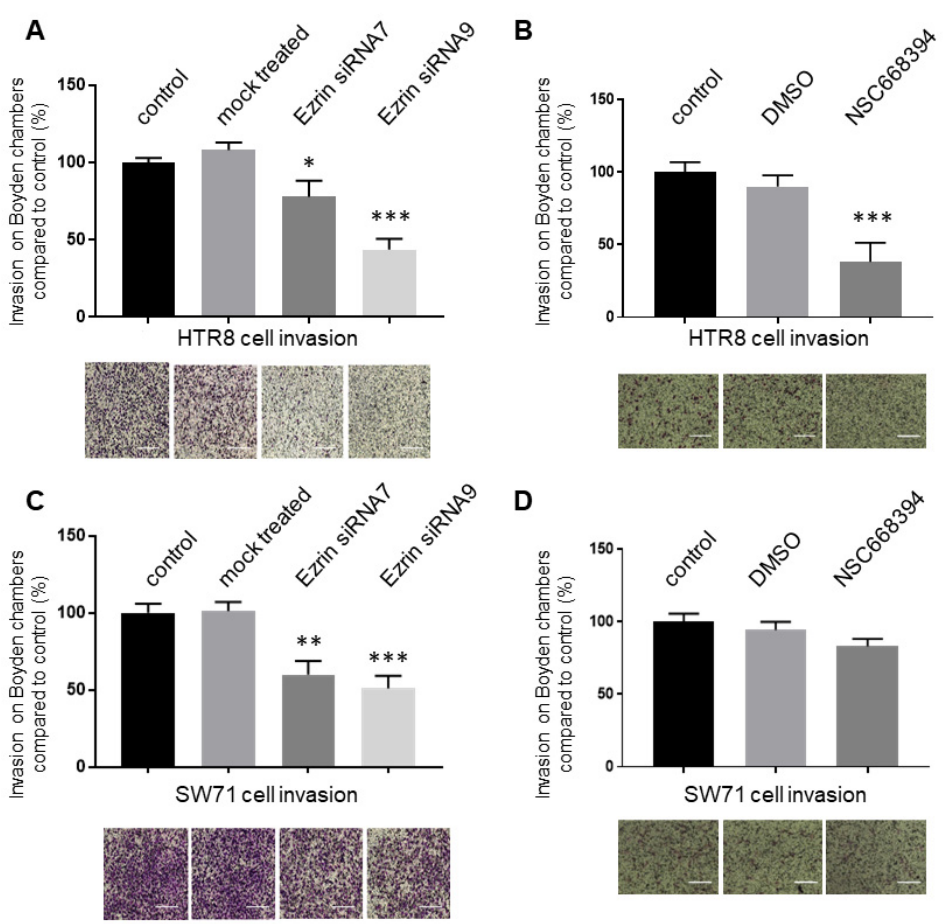
Figure 5. Reduced ezrin levels or its Thr567phosphorylation results in the differentially reduced cellular invasion of HTR8/SVneo and Swan71 trophoblasts. HTR8/SVneo and Swan71 cells were incubated in the presence of different ezrin siRNAs or control siRNAs for 72 h ( A , C ) or treated with NSC668394 inhibitors for 24 h ( B , D ) prior to starvation with low-serum-containing medium. After 24 h, cells were seeded into Matrigel-coated Boyden chambers for 16 h prior to fixation and staining using the Diffquik histochemical kit for the labelling of both nuclei and cytoplasm ( A – D ). Five random fields were quantified for each chamber. Data are presented as the means ± SEM of 4 independent experiments relative to controls (percentage) from 4 replicate wells for each set of conditions. * p < 0.05, ** p < 0.01 or *** p < 0.001 compared to the control and mock treatments (one-way ANOVA). Images of representative fields of motility/invasion assays were taken with the EVOS XL Cell Imaging System at 20× magnification ( A – D ). Bar corresponds to 100 μ m.